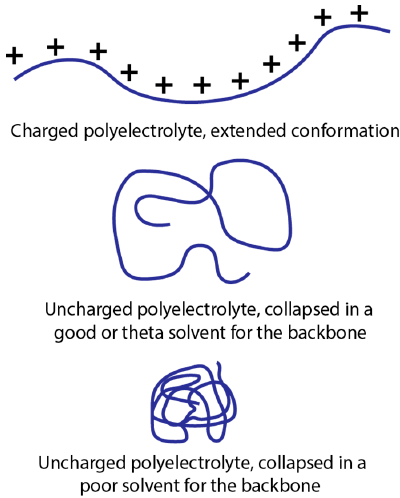
Figure 2. Schematic of charged polyelectrolyte conformation in good, theta, or poor solvents.